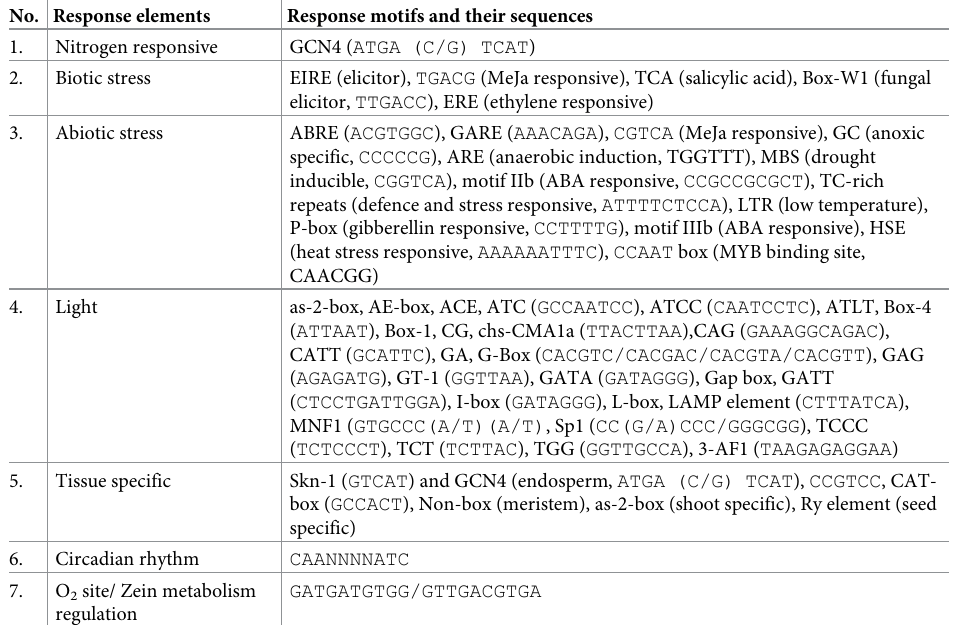
Table 3. A summary of cis-acting regulatory elements for abiotic stress in promoters of TaRKD and TaNLP genes of